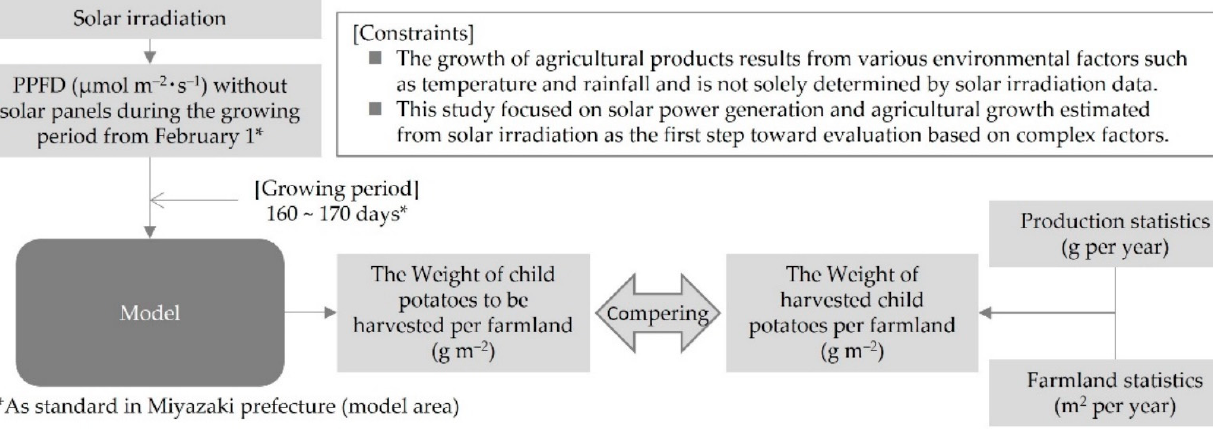
Figure 6. Methods for verifying model.